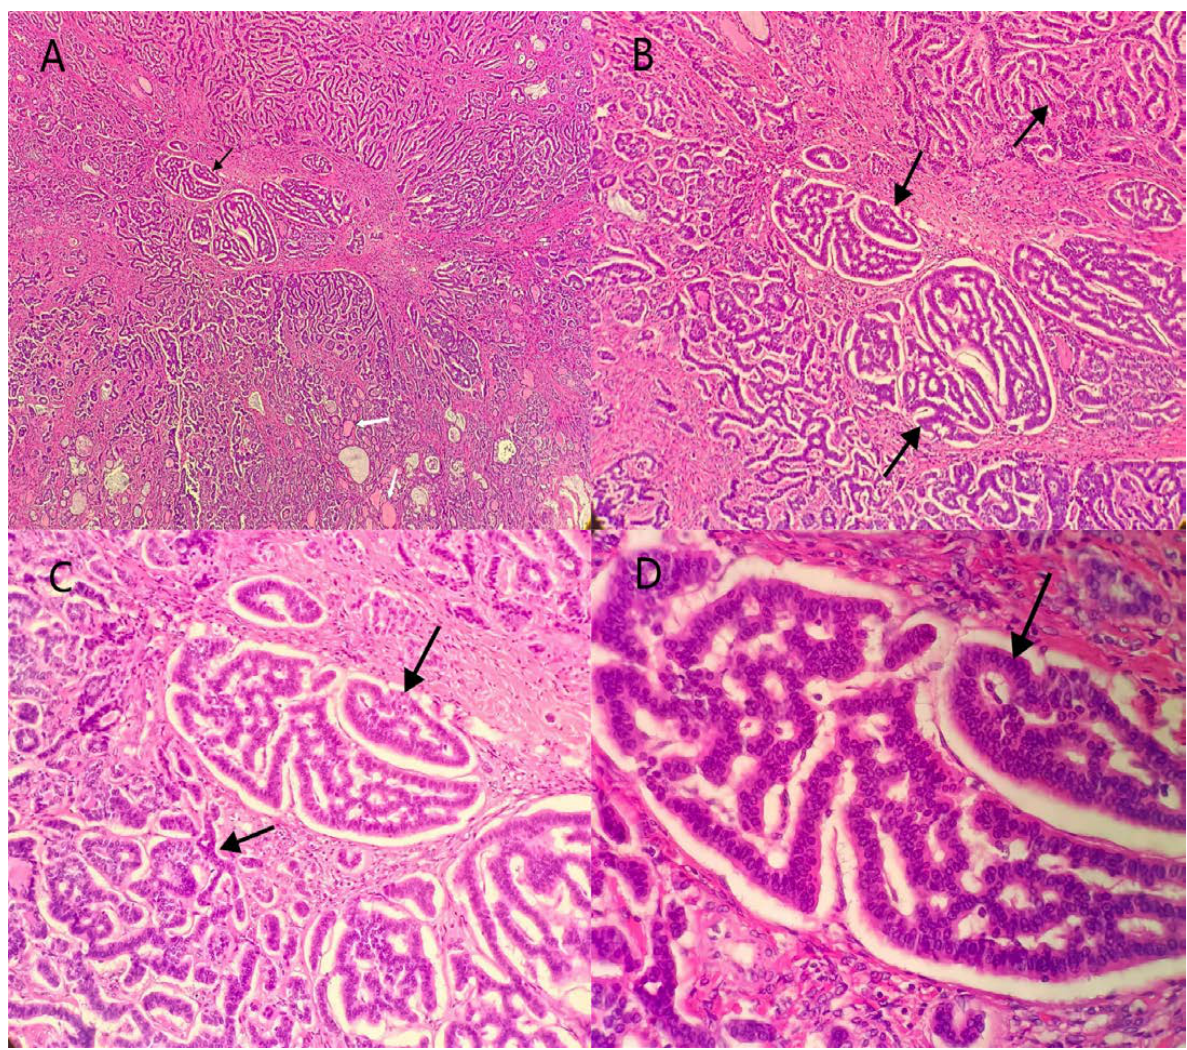
Figure 3. Strumal components: thyroid follicles of different sizes (white arrow);Hematoxylin-eosin staining of the strumal carcinoid tumor. The strumal component can be seen in the tumor parenchyma (black arrow). ( A ): H&E × 40; ( B ): H&E × 100; ( C ): H&E × 200; ( D ): H&E × 400.